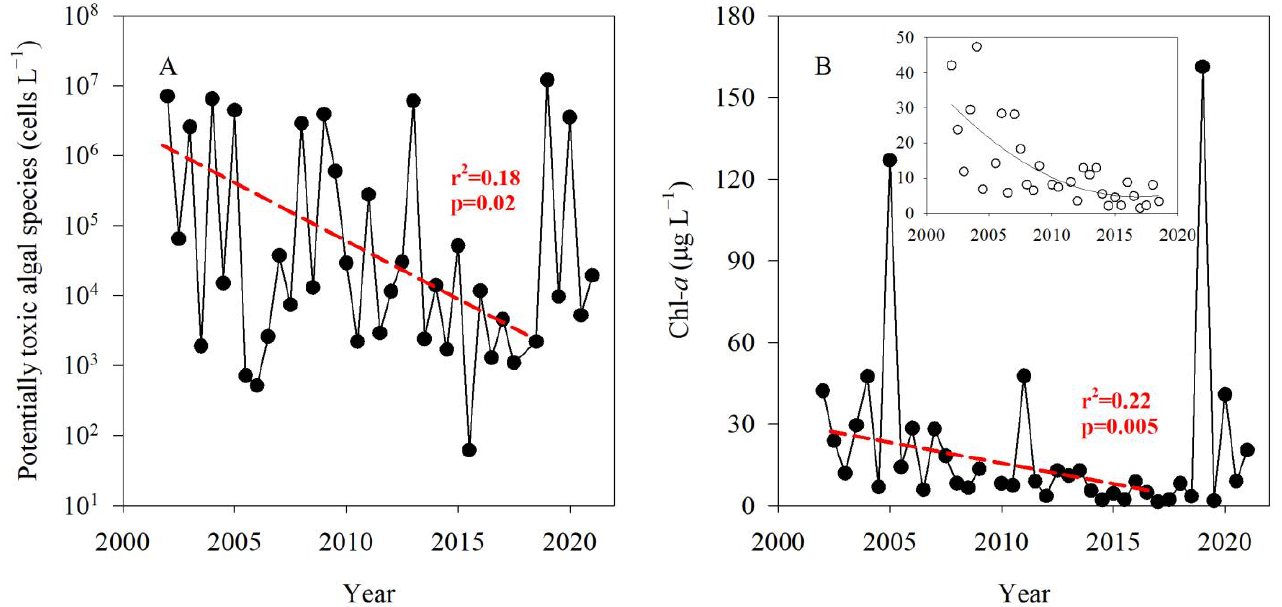
Figure 6. Temporal variability of potentially toxic alga abundance ( A ) and chl- a ( B ) in the Kishon’s Harbor station between 2002 – 2021. The red lines indicate the decreasing trend in 2002 – 2018 for both potentially toxic alga ( A ) and chl- a ( B ). Insert: chl- a levels between 2002 – 2018 excluding ‘abnormal’ peaks in 2005 and 2011.